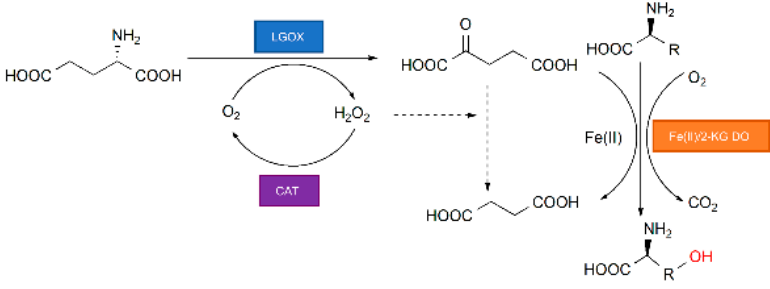
Figure Figure 1. Multi-enzymatic cascade system for hydroxy amino acid synthesis by combining Fe(II)/2- ketoglutarate-dependent dioxygenase (Fe(II)/2-KG DO), L -glutamate oxidase (LGOX), and catalase (CAT).